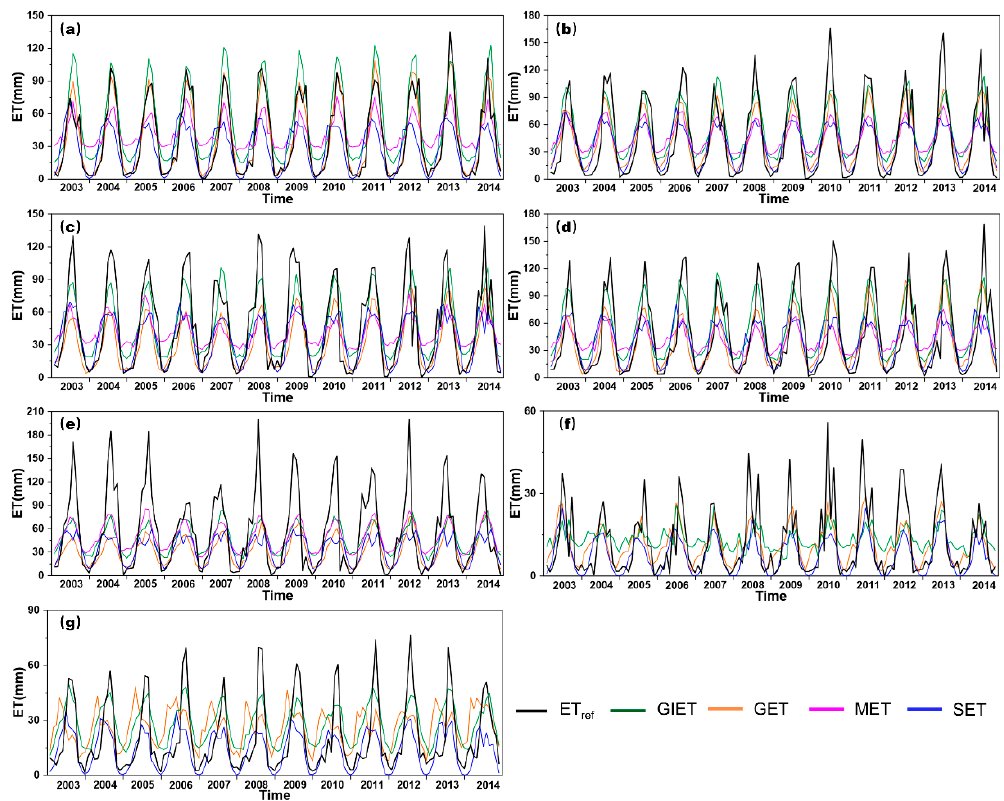
Figure 6. Monthly time series from the mean values of the four ET p (mm) and the ET ref (mm) during 2003–2014. ( a ) Yellow River source region; ( b ) Yangtze River source region; ( c ) Salween River source region; ( d ) Mekong River source region; ( e ) Yarlung Zangbo Basin; ( f ) Qaidam Basin; and( g ) Inner Plateau.